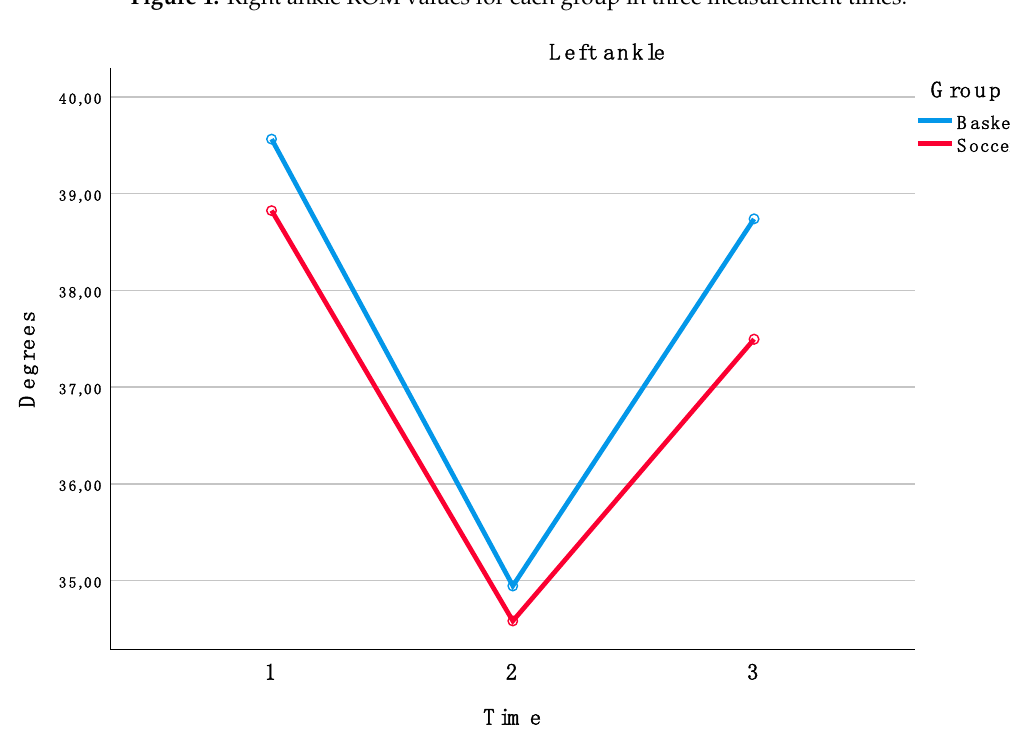
Figure 1. Right ankle ROM values for each group in three measurement times.